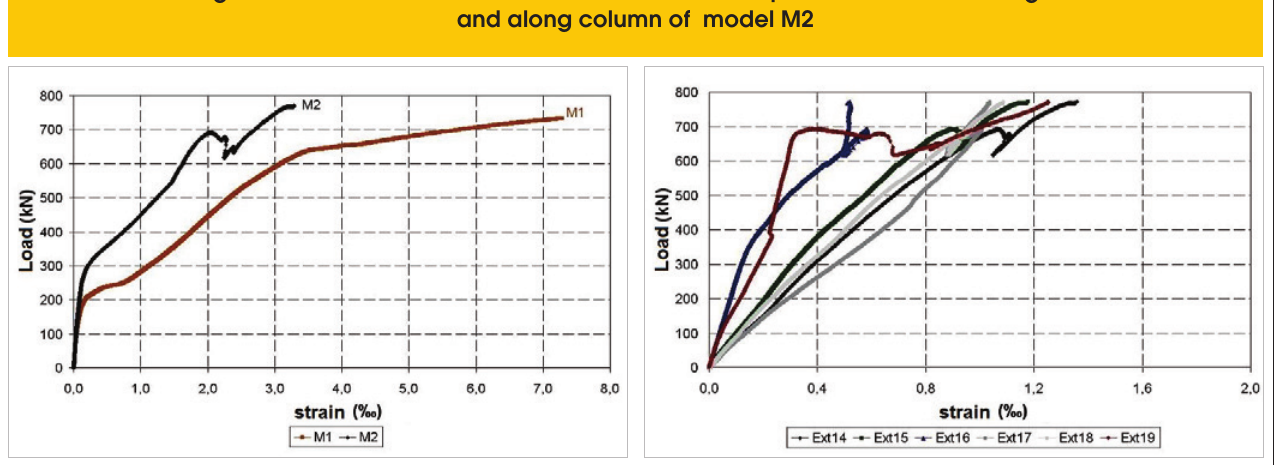
Figure 10 – Load-strain curve on reinforcement bars positioned in central region and along column of model